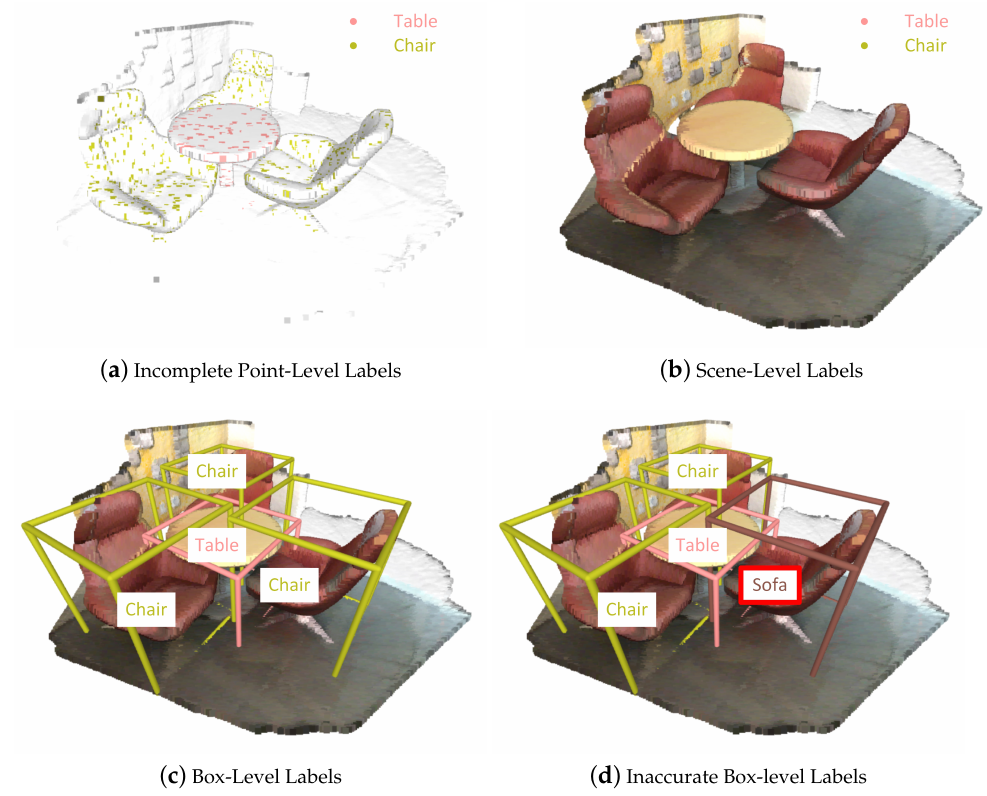
Figure 1. Illustration of various weak supervision methods for point cloud segmenta- tion. ( a ) Incomplete point-level labels denote the classes to which a small fraction of points belong. ( b ) Scene-level (subcloud-level) labels indicate all of the classes appearing in the scene (sub- cloud). ( c ) Box-level labels indicate the class and location of each object. ( d ) Inaccurate box-level labels indicate the portion of boxes that are mislabeled. For example, a “chair” is mislabelled as a